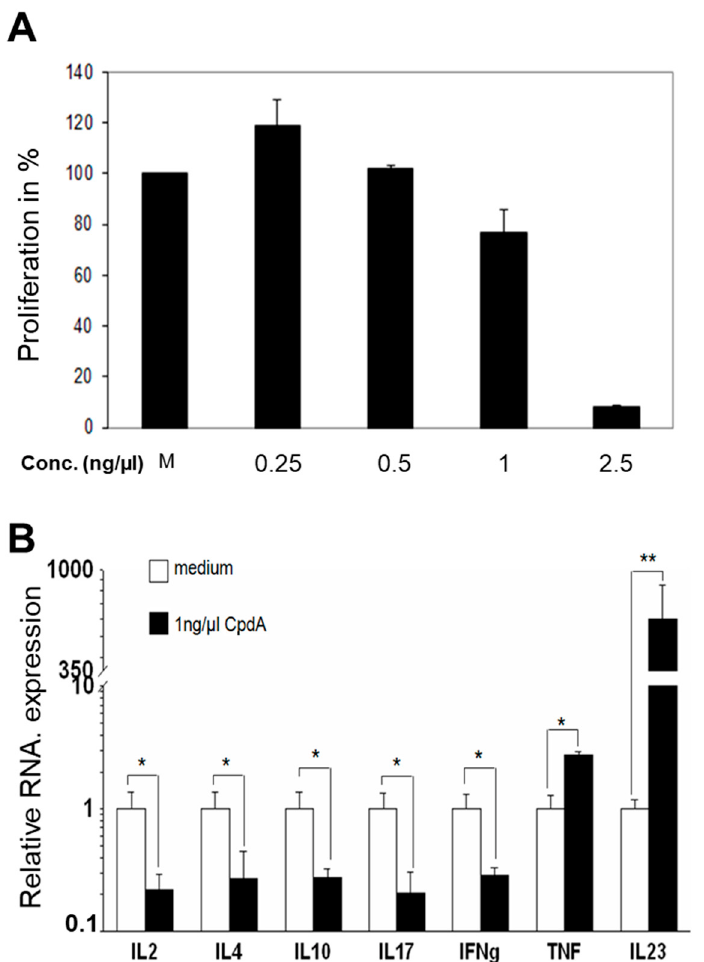
Figure 1. Mixed lymphocyte reaction (MLR) proliferation assay and cytokine expression. The MLR was performed as described in the Materials and Methods section. ( A ) T cell proliferation in response to alloantigen stimulation with different doses of CpdA. ( B ) mRNA expression levels in cells measured using real-time PCR after the MLR. CpdA concentration indicates the amount added during bulk MLR. The combined results from the two experiments are shown, and the data are presented as mean ± SEM; * p < 0.05, ** p < 0.01.